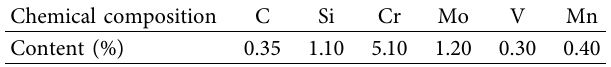
Table 1: Chemical composition of grade AISI H11 steel [41].